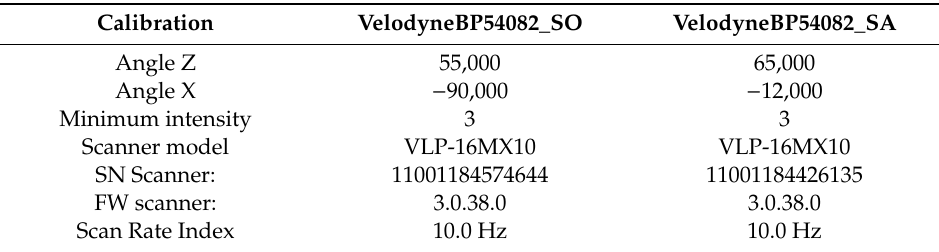
Table 4. Presentation of processing data for Velodyne SO and